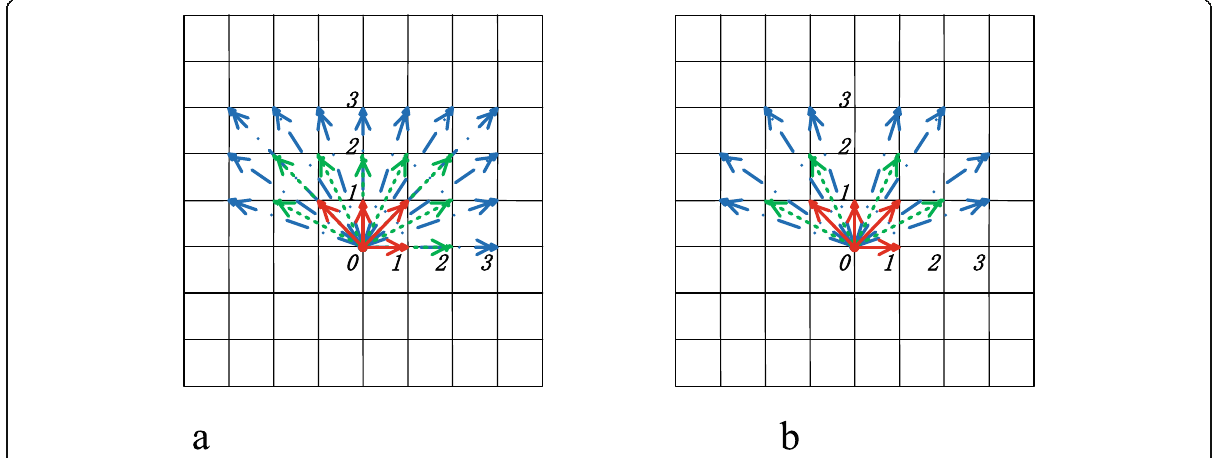
Fig. 6 Two cases of multiple angle sampling: ( a ) multiple angle sampling with duplicates, ( b ) multiple angle sampling without duplicates